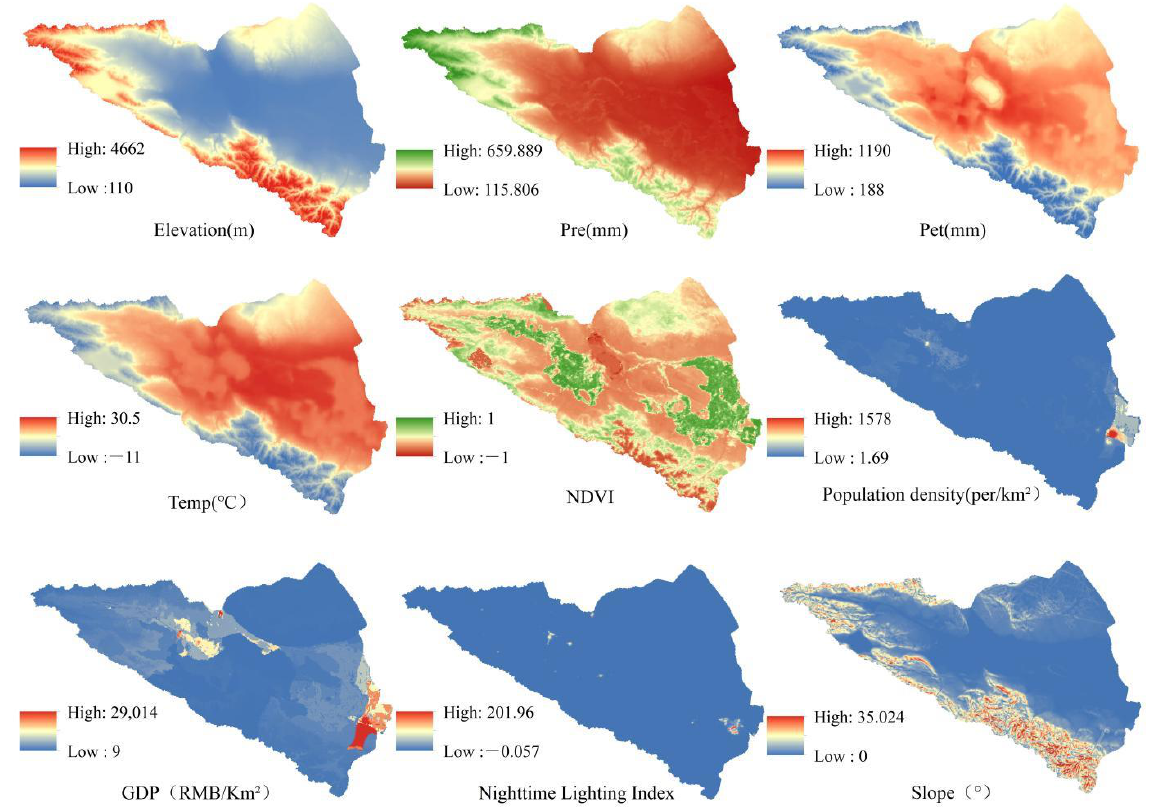
Figure 3. Map of impact factors for future land-use